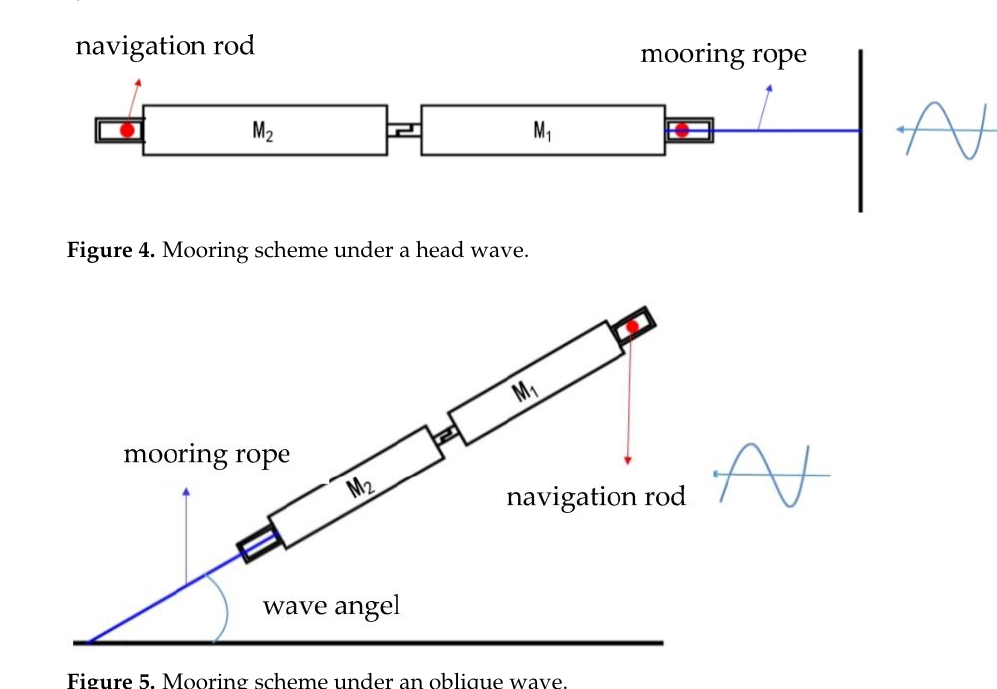
Figure 3. The mooring system and the floating body. ( a ) The navigation board. ( b ) The mooring system.